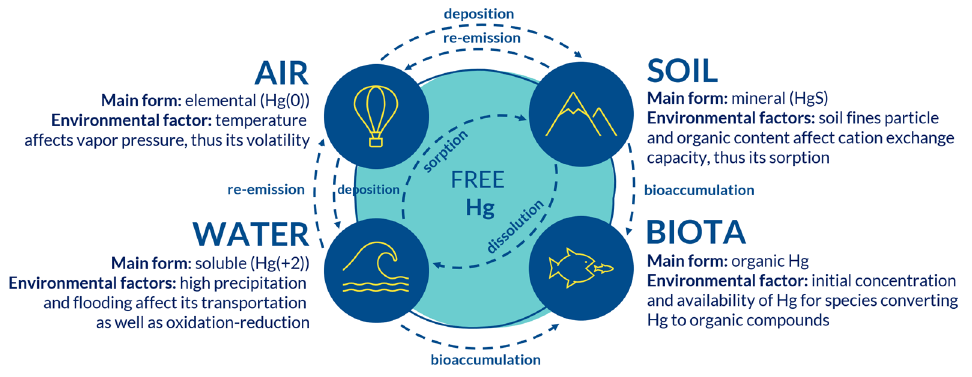
Figure 2. Main forms of Hg and environmental factors affecting Hg presence in different media.